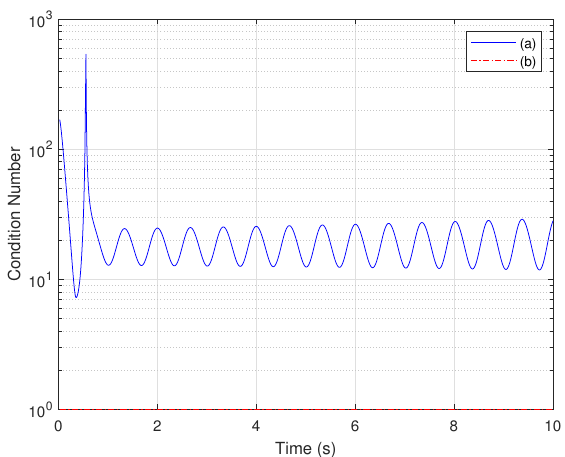
Figure 7. gPC-based observability Gramian analysis: condition number of observability matrix: (a) first-order coefficient matrix and (b) active coefficient